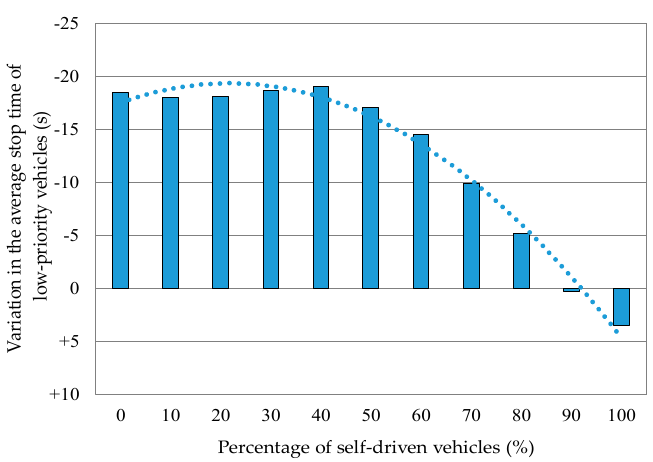
Figure 15. Variation in the average stop time of low-priority vehicles when the percentage of self-driven vehicles was varied. The average stop time was the average for all the vehicles that came in.